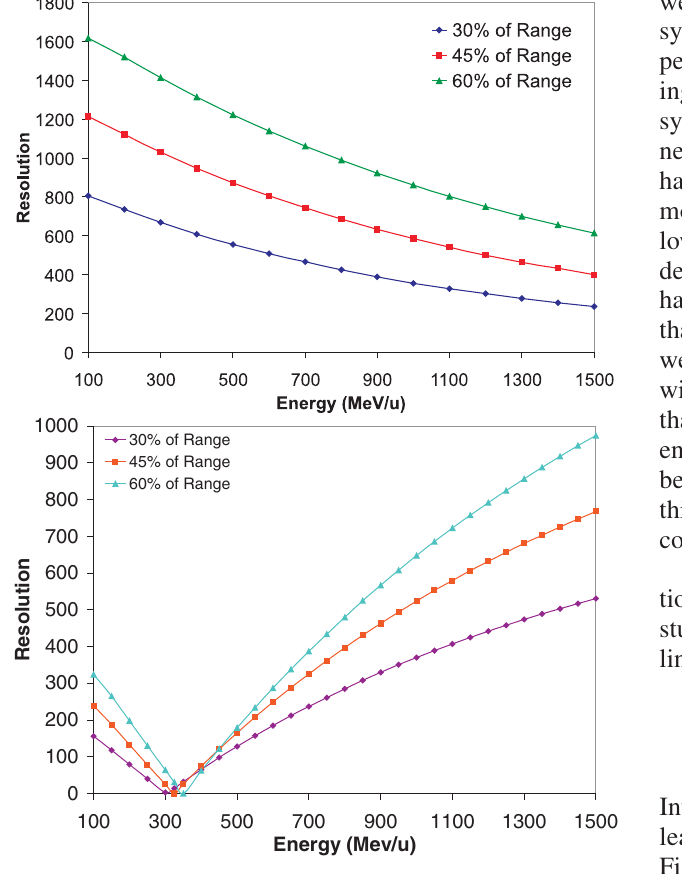
FIG. 13. (Color) Mass (upper) and charge (lower) linear resolv- ing powers as a function of energy for three different wedge thicknesses.